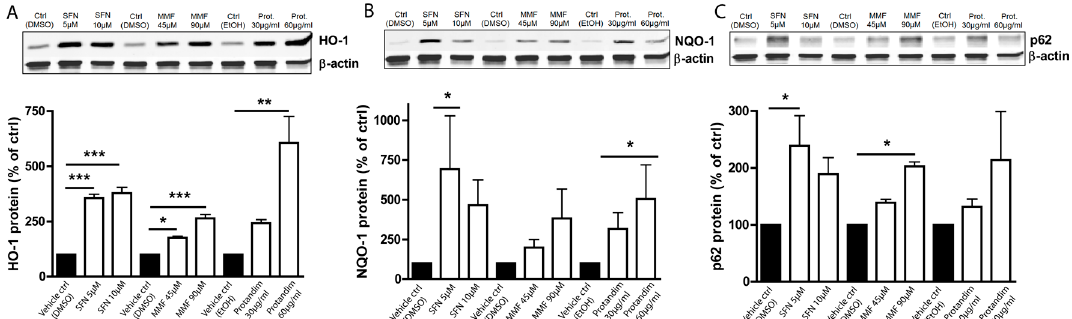
Figure 1. Nrf2-activators dose-dependently increase antioxidant protein expression in OLN-93 cells. HO-1 ( A ), NQO-1 ( B ) and p62 ( C ) protein expression levels after 24 h treatment in the OLN-93 oligodendrocyte cell line with 5 µ M or 10 µ M SFN, 45 µ M or 90 µ M MMF, 30 µ g/mL or 60 µ g/mL Protandim or their respective DMSO or EtOH vehicle control. Protein levels were assayed by Western blotting. Data are presented as percentage of control and expressed as the mean ± SEM of 3 independent experiments. All statistics reflect one-way ANOVA tests with post hoc Bonferroni correction; * p < 0.05, ** p < 0.01; *** p < 0.001.